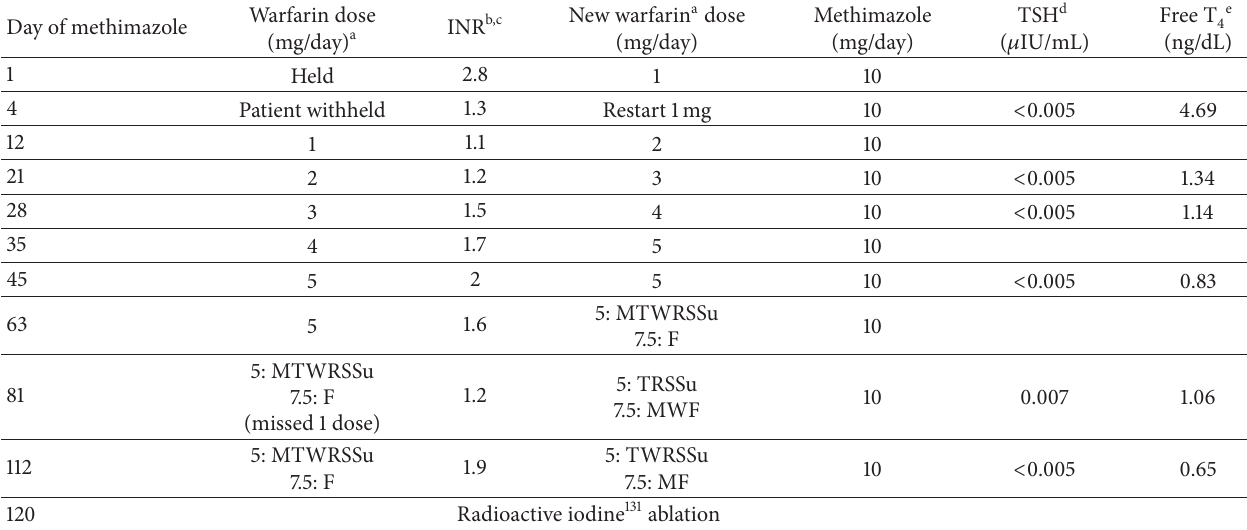
Table 2: Outpatient warfarin response to the addition of